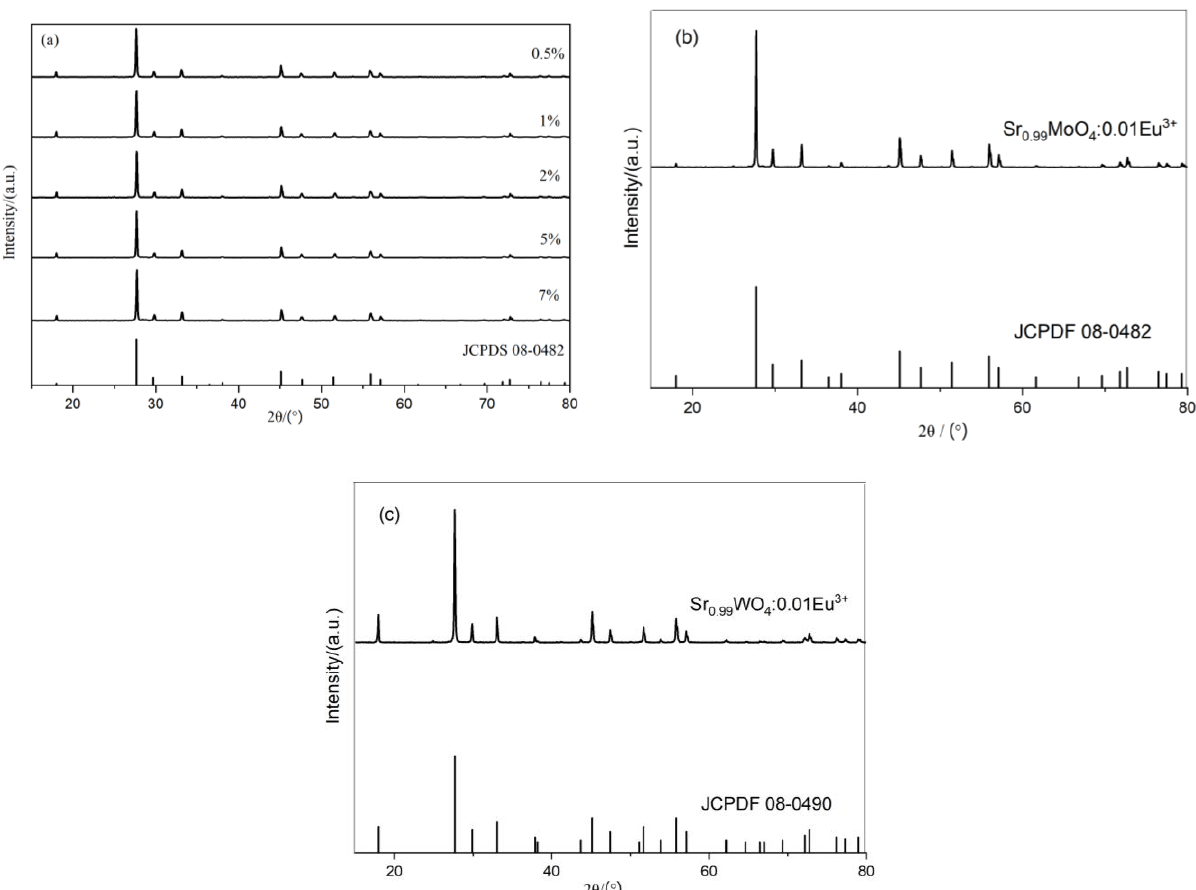
Figure 2. XRD of ( a ) Sr 1 − x Mo 0.5 W 0.5 O 4 :xEu 3+ , ( b ) Sr 0.99 MoO 4 :0.01Eu 3+ and ( c ) Sr 0.99 WO 4 :0.01Eu 3+ . The electrovalent imbalance induced by the unequal substitution of Sr 2+ with Eu 3+ in the Sr 0.99 Mo 0.5 W 0.5 O 4 :0.01Eu 3+ system can be rectified by adding charge compensators [31].